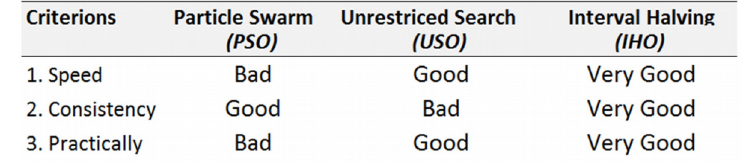
Table 5. Comparison of the results among the three of the optimization algorithms